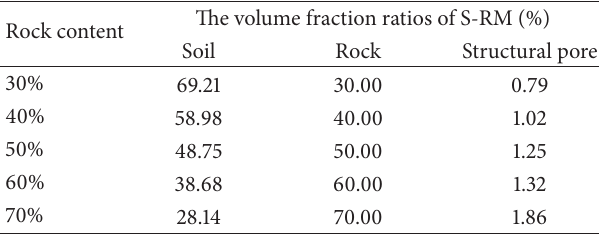
Table 1: Volume fraction ratios of S-RM with different rock con- tents.